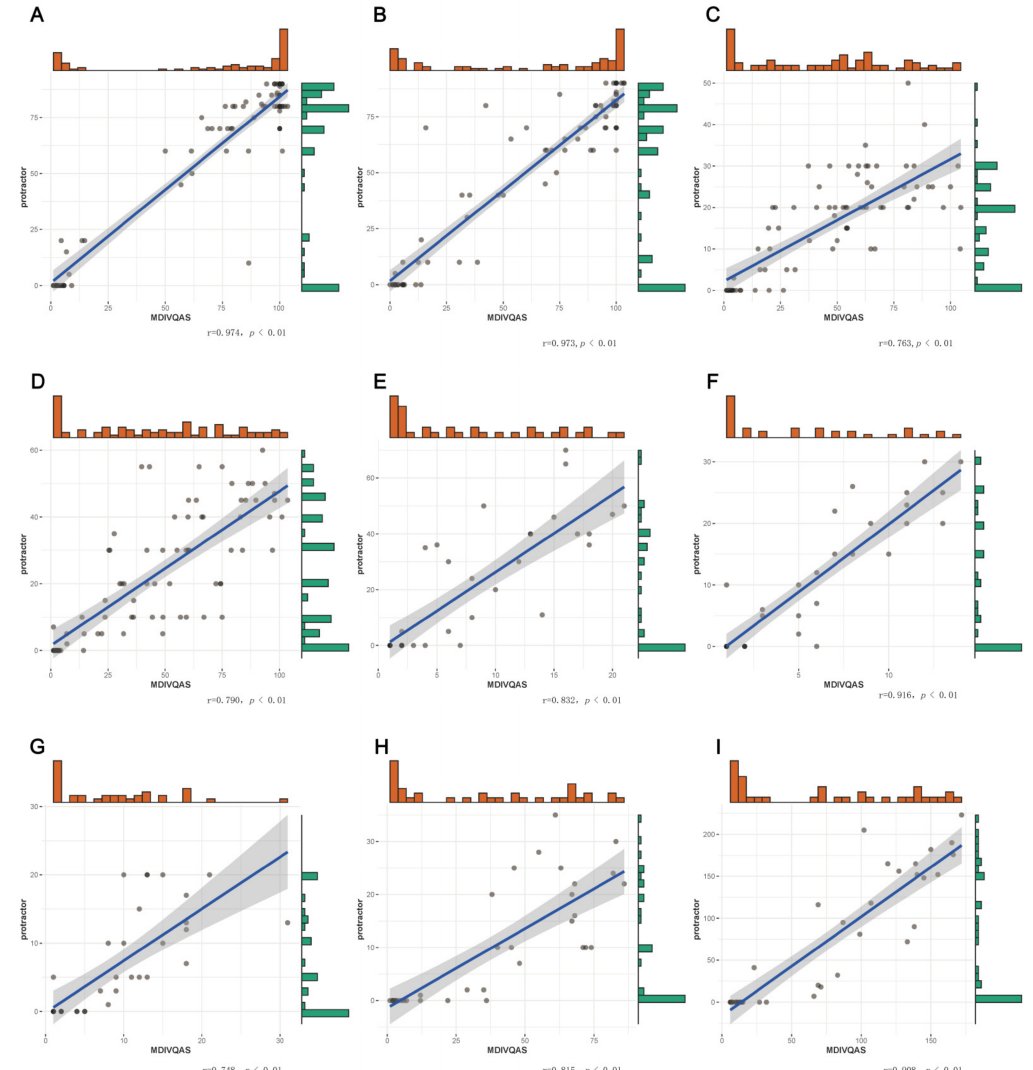
Figure 7. Correlation between MDIVQAS and protractor measurement. ( A ) Forearm pronation; ( B ) Forearm supination; ( C ) Ulnar deviation of wrist; ( D ) wrist dorsiextension; ( E ) Finger adduc- tion and abduction1; ( F ) Finger adduction and abduction2; ( G ) Finger adduction and abduction3; ( H ) Finger adduction and abduction4; ( I ) Sum of finger adduction and